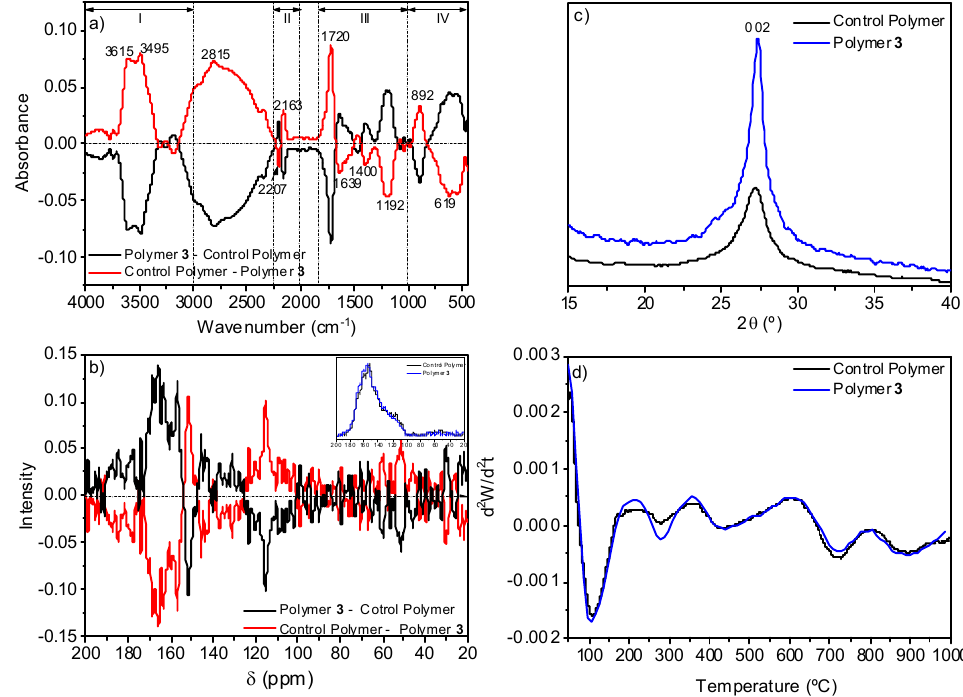
Figure 8. Comparative spectroscopic and thermal studies between polymer 3 and a control polymer synthetized using conventional heating. ( a ) Substation of the FTIR spectra; ( b ) substation of the 13 C NMR spectra; ( c ) XRD patters; ( d ) second derivative of the TG curves.